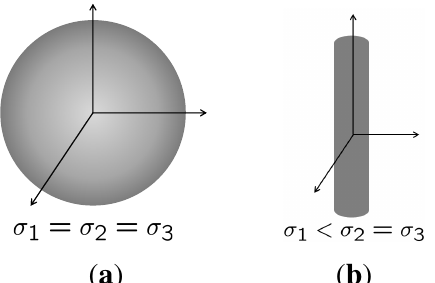
Figure 5. Relationship of three eigenvalues of the moment-of-inertia filter. ( a ) globular; ( b )